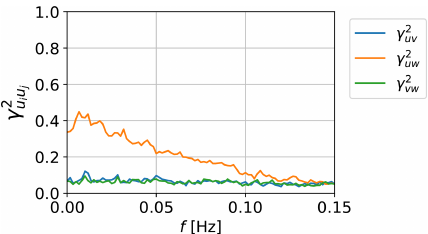
Figure 15. Mean cross-coherence for points at a plane at